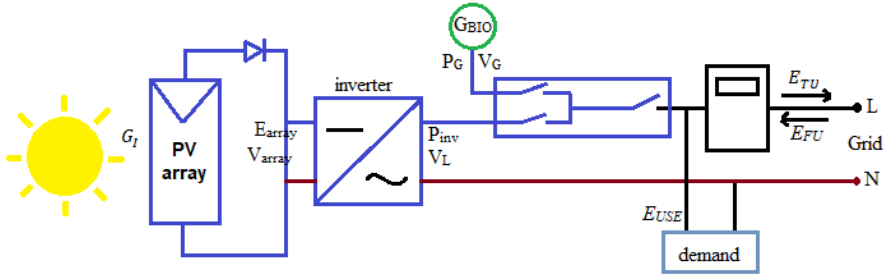
Figure 1. Parameters of the desired hybrid system to be measured in real time.